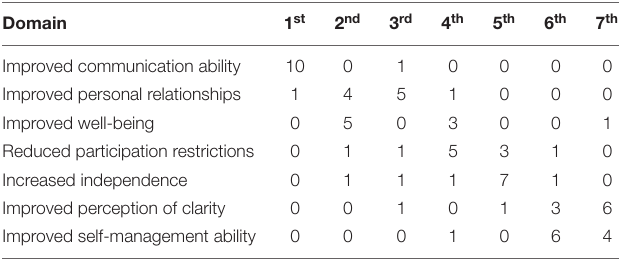
TABLE 9 | Summary of rankings of individual domains provided by participants in the consensus workshop.